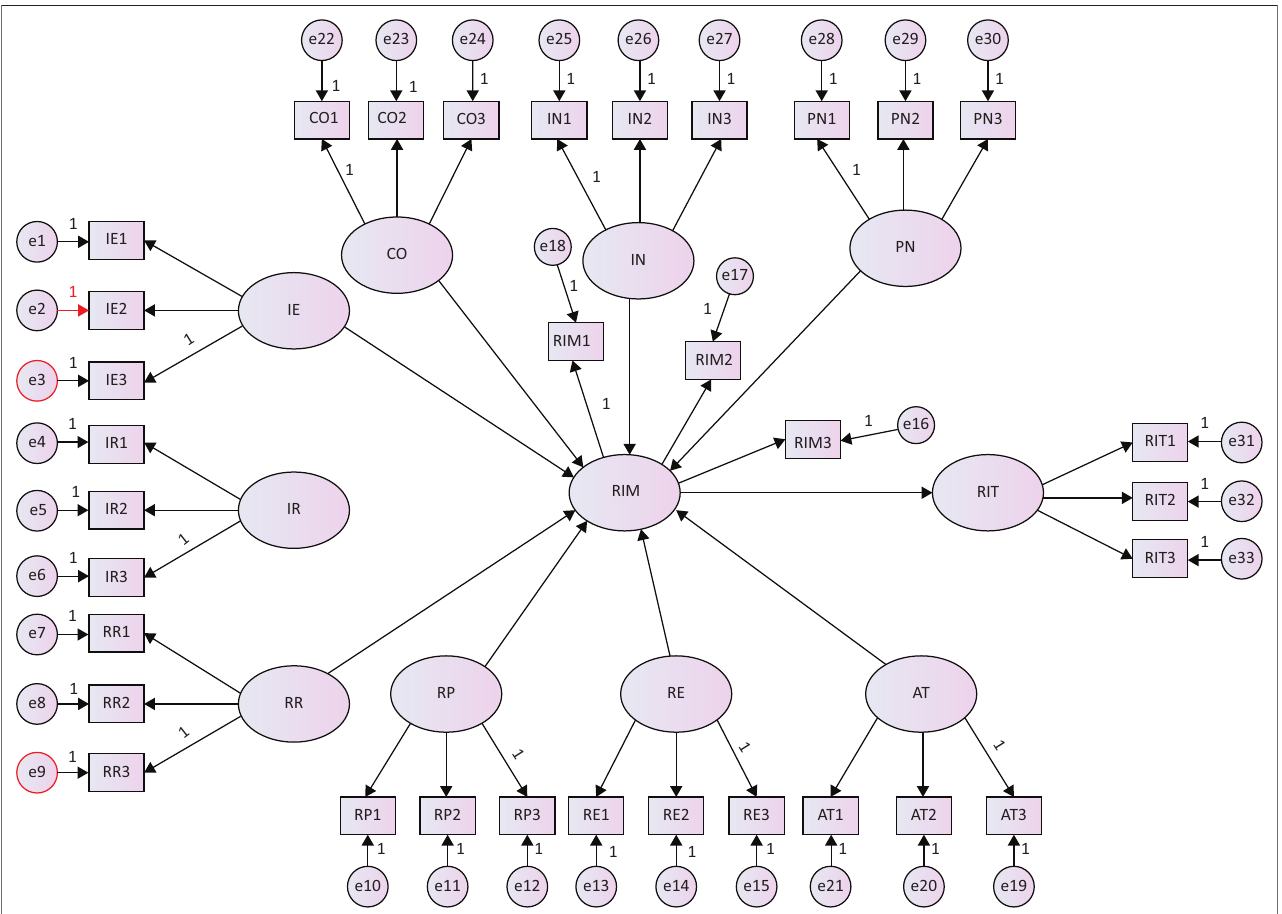
FIGURE 3: The measurement